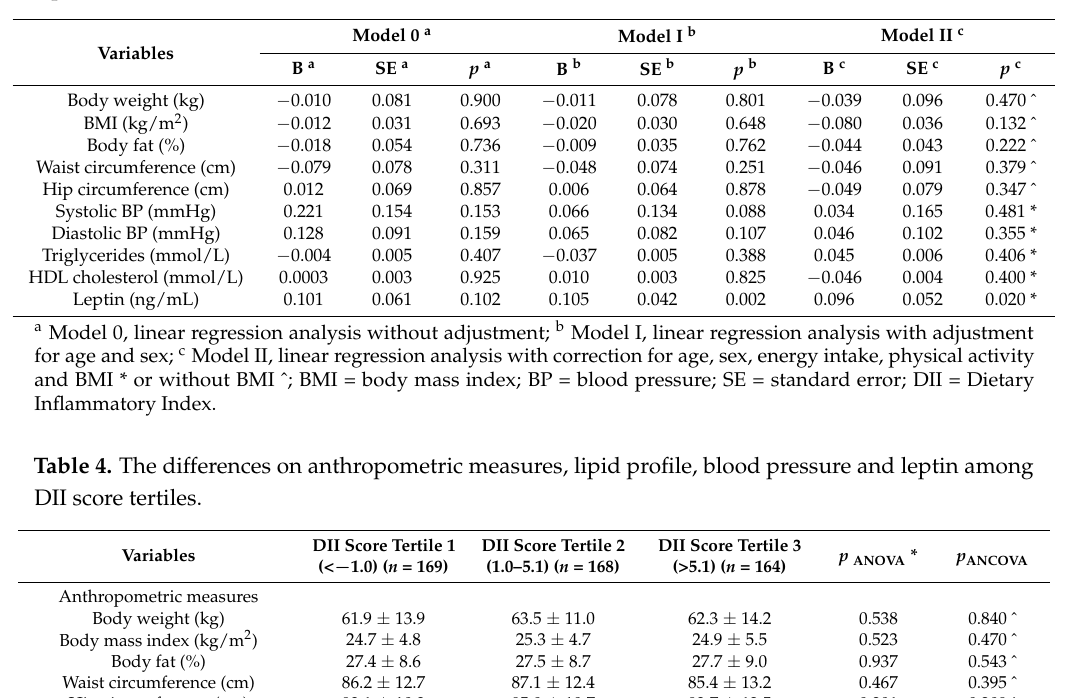
Table 3. Standardized regression coefficients (B) and their standard error (SE) and p -value of the association between DII score and anthropometric variables, blood pressure, lipid profile, and leptin concentration.